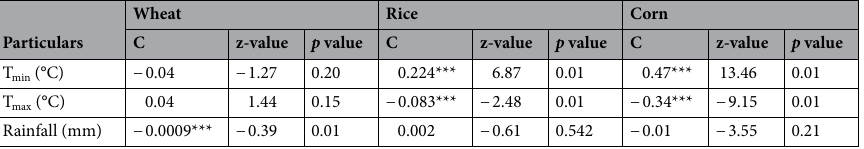
Table 6. Marginal effects of climate change on major cereal crop yields in the SE-US, 1980–2020. ***Denotes significance at the 1% level; C represents the regression coefficient of marginal effects.